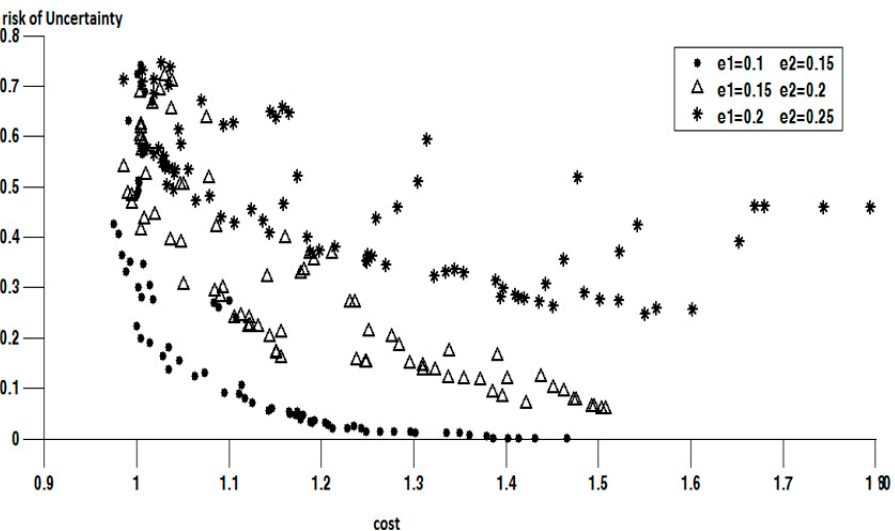
Figure 11. Two-dimensional diagram of economic objective function and instability risk in different experiments.